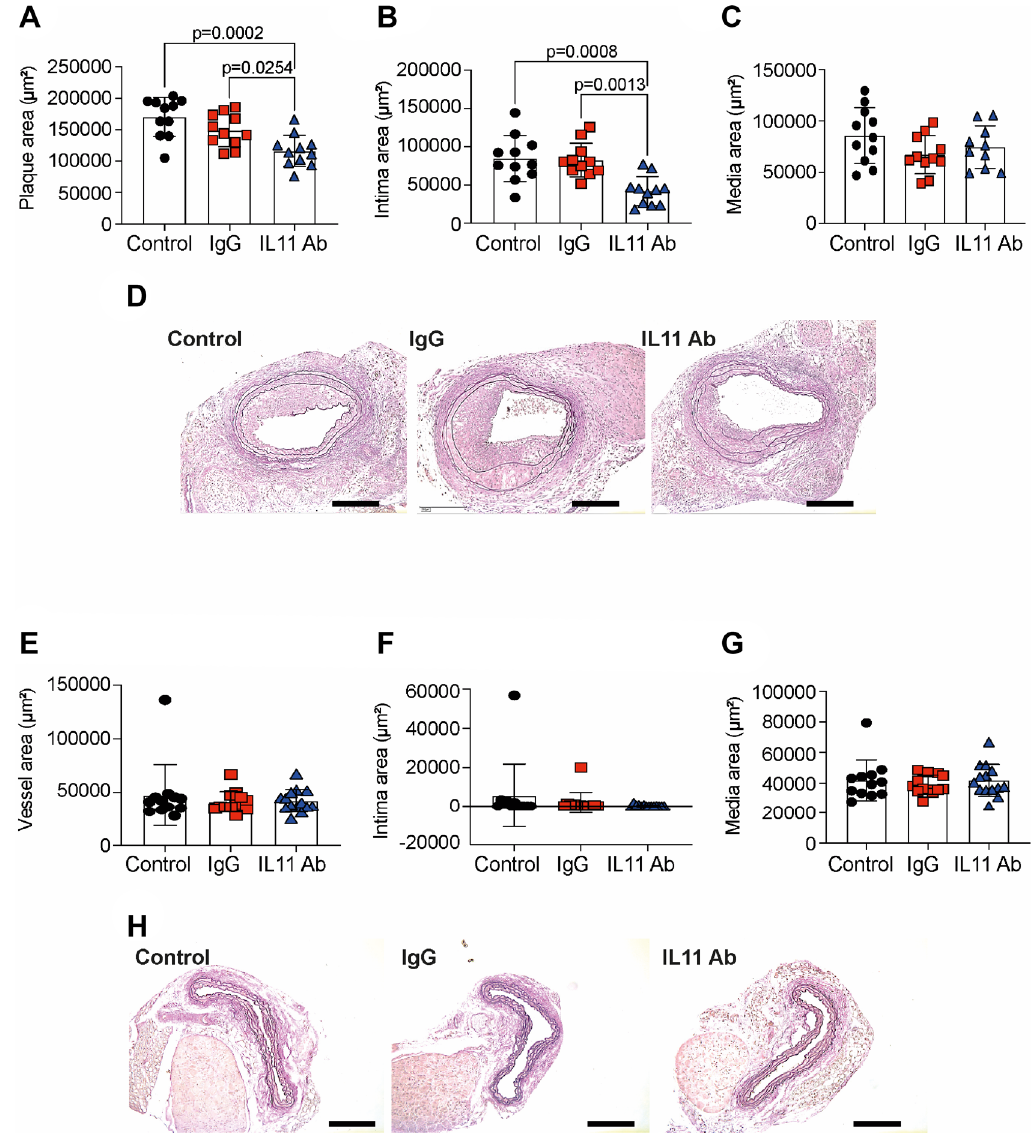
Figure 3. The effect of anti-IL-11 antibody (X203) treatment on neointimal hyperplasia. ( A ) Injury-related plaque area (N = 11/group, One-way ANOVA, Tukey’s multiple comparison test, Values ± SD). ( B ) Intima area (N = 11/group, One-way ANOVA, Tukey’s multiple comparison test, Values ± SD). ( C ) Media area (N = 11/group, One-way ANOVA, Tukey’s multiple comparison test, Values ± SD). ( D ) Representative images of Verhoeff Van Gieson Elastic stain (scale bar 200 μm). ( E ) Vessel area of control uninjured right carotid arteries (N = 12–14/ group, One-way ANOVA, Tukey’s multiple comparison test, Values ± SD). ( F ) Intima area (N = 12–14/group, One-way ANOVA, Tukey’s multiple comparison test, Values ± SD). ( G ) Media area (N = 12–14/group, One-way ANOVA, Tukey’s multiple comparison test, Values ± SD). ( H ) Representative images of Verhoeff Van Gieson Elastic stain (scale bar 200